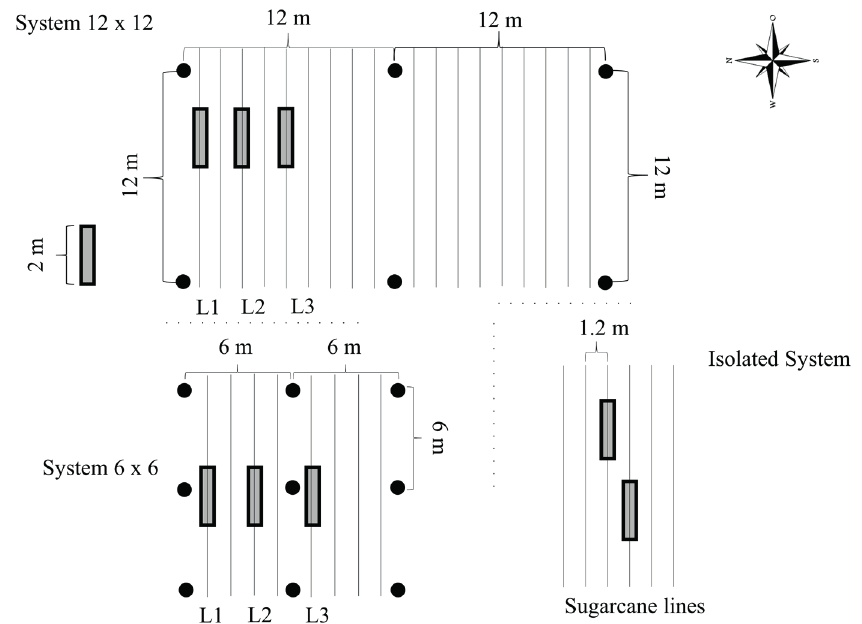
Figure 1 - A sketch of an experimental unit of the agroforestry systems (12 x 12 and 6 x 6) and the isolated system. Black circles represent the trees, continuous lines indicate where the sugarcane was planted, and the rectangles in grey represent the monthly evaluation plots of